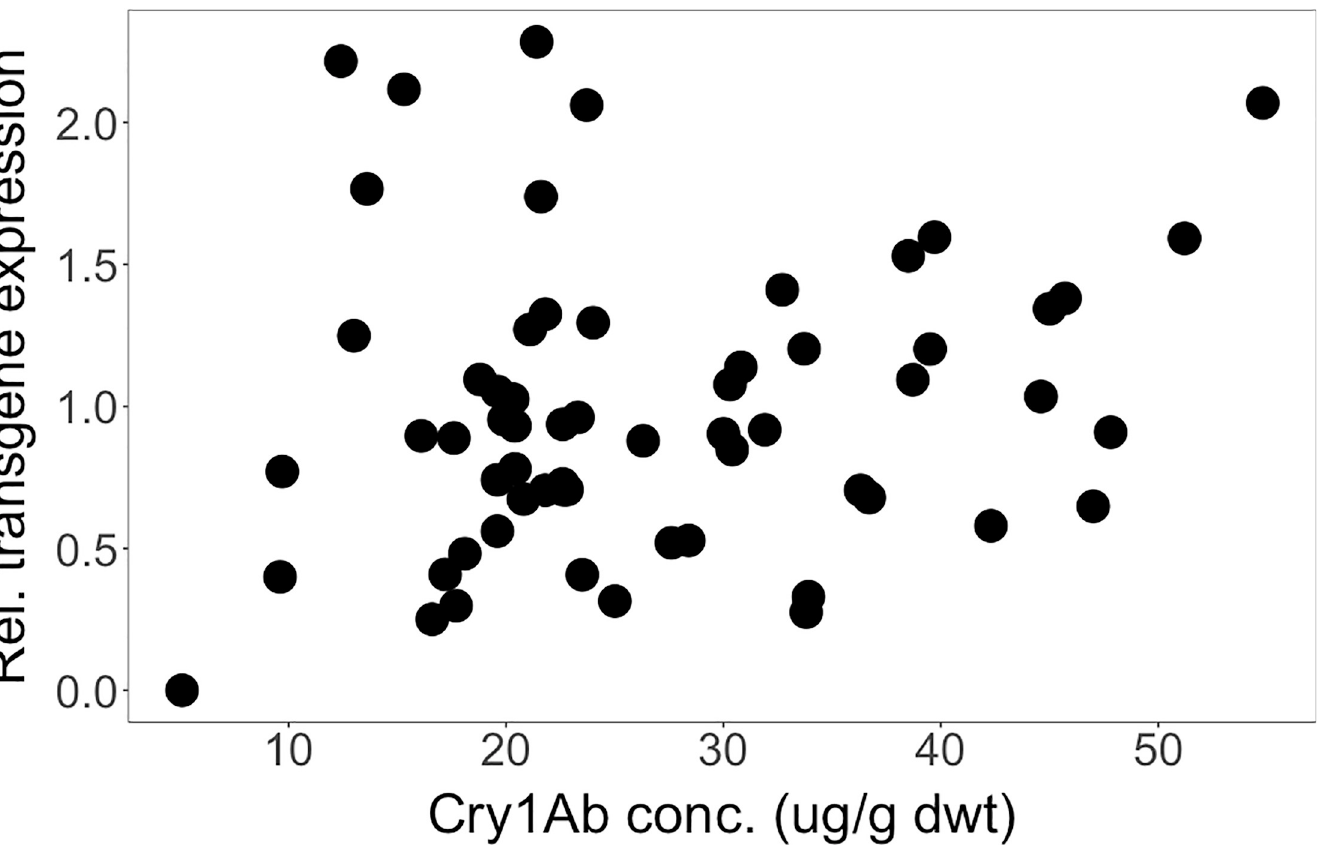
Fig 5. Spearman rank correlation between relative transgene expression and Cry1Ab concentration across different genetic backgrounds from South Africa. ( Rs = 0.169, P = 0.190).